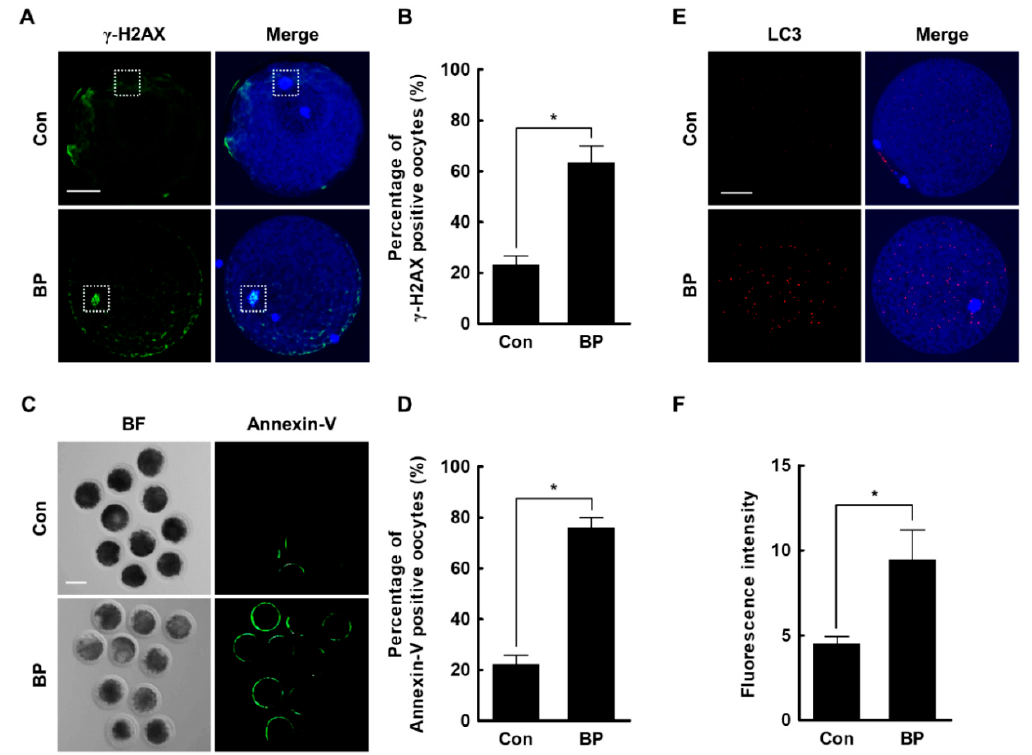
Figure 5. E ff ects of butylparaben (BP) exposure during in vitro maturation (IVM) on DNA damage, early apoptosis, and autophagy. ( A ) Fluorescence images of oocytes stained with an antibody against γ -H2AX in the BP-treated and control groups. Bar = 50 µ M. ( B ) Percentage of γ -H2AX-positive oocytes in the BP-treated and control groups (Con; n = 30, BP; n = 30). ( C ) Fluorescence images of oocytes stained with annexin V in the BP-treated and control groups. Bar = 100 µ M. ( D ) Percentage of annexin V-positive oocytes in the BP-treated and control groups (Con; n = 50, BP; n = 50). ( E ) Fluorescence images of oocytes stained with an antibody directed against LC3 in the BP-treated and control groups. Bar = 50 µ M. ( F ) Quantification of the fluorescence intensity in the BP-treated and control groups (Con; n = 26, BP; n = 26). The data are from three independent experiments and the values represent the mean ± SEM. * p < 0.05.